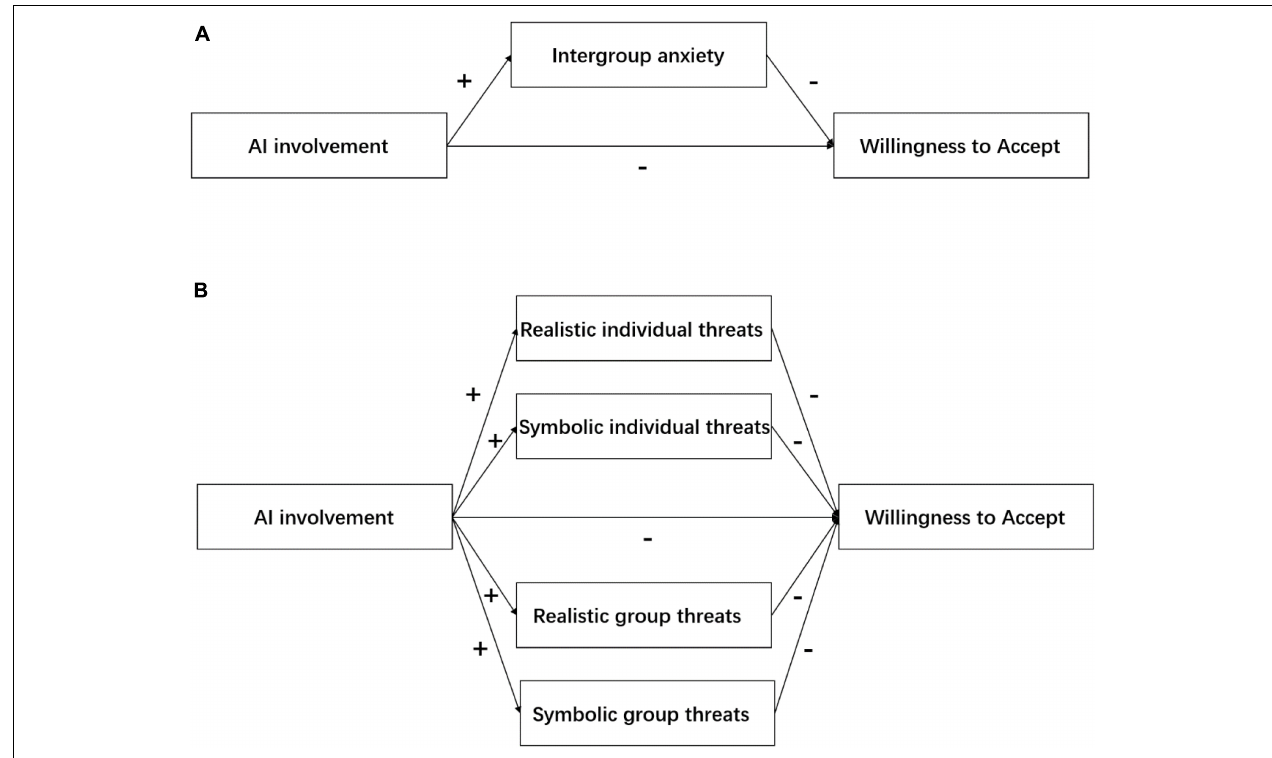
FIGURE 1 | (A) The research model of experiment 1. (B) The research model of experiment 2.